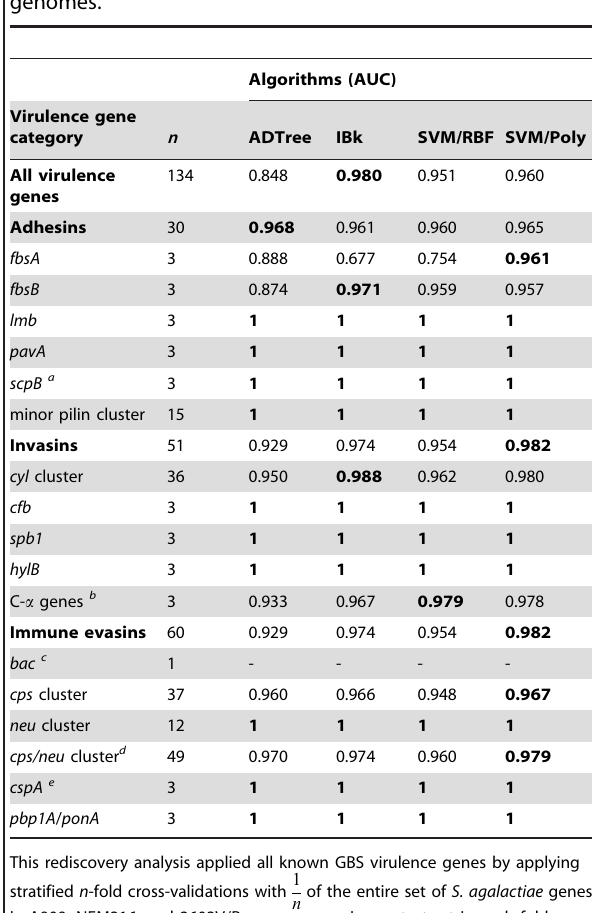
Table 3. The performance of inductive CGP algorithms in the rediscovery of known virulence genes in all 3 GBS reference